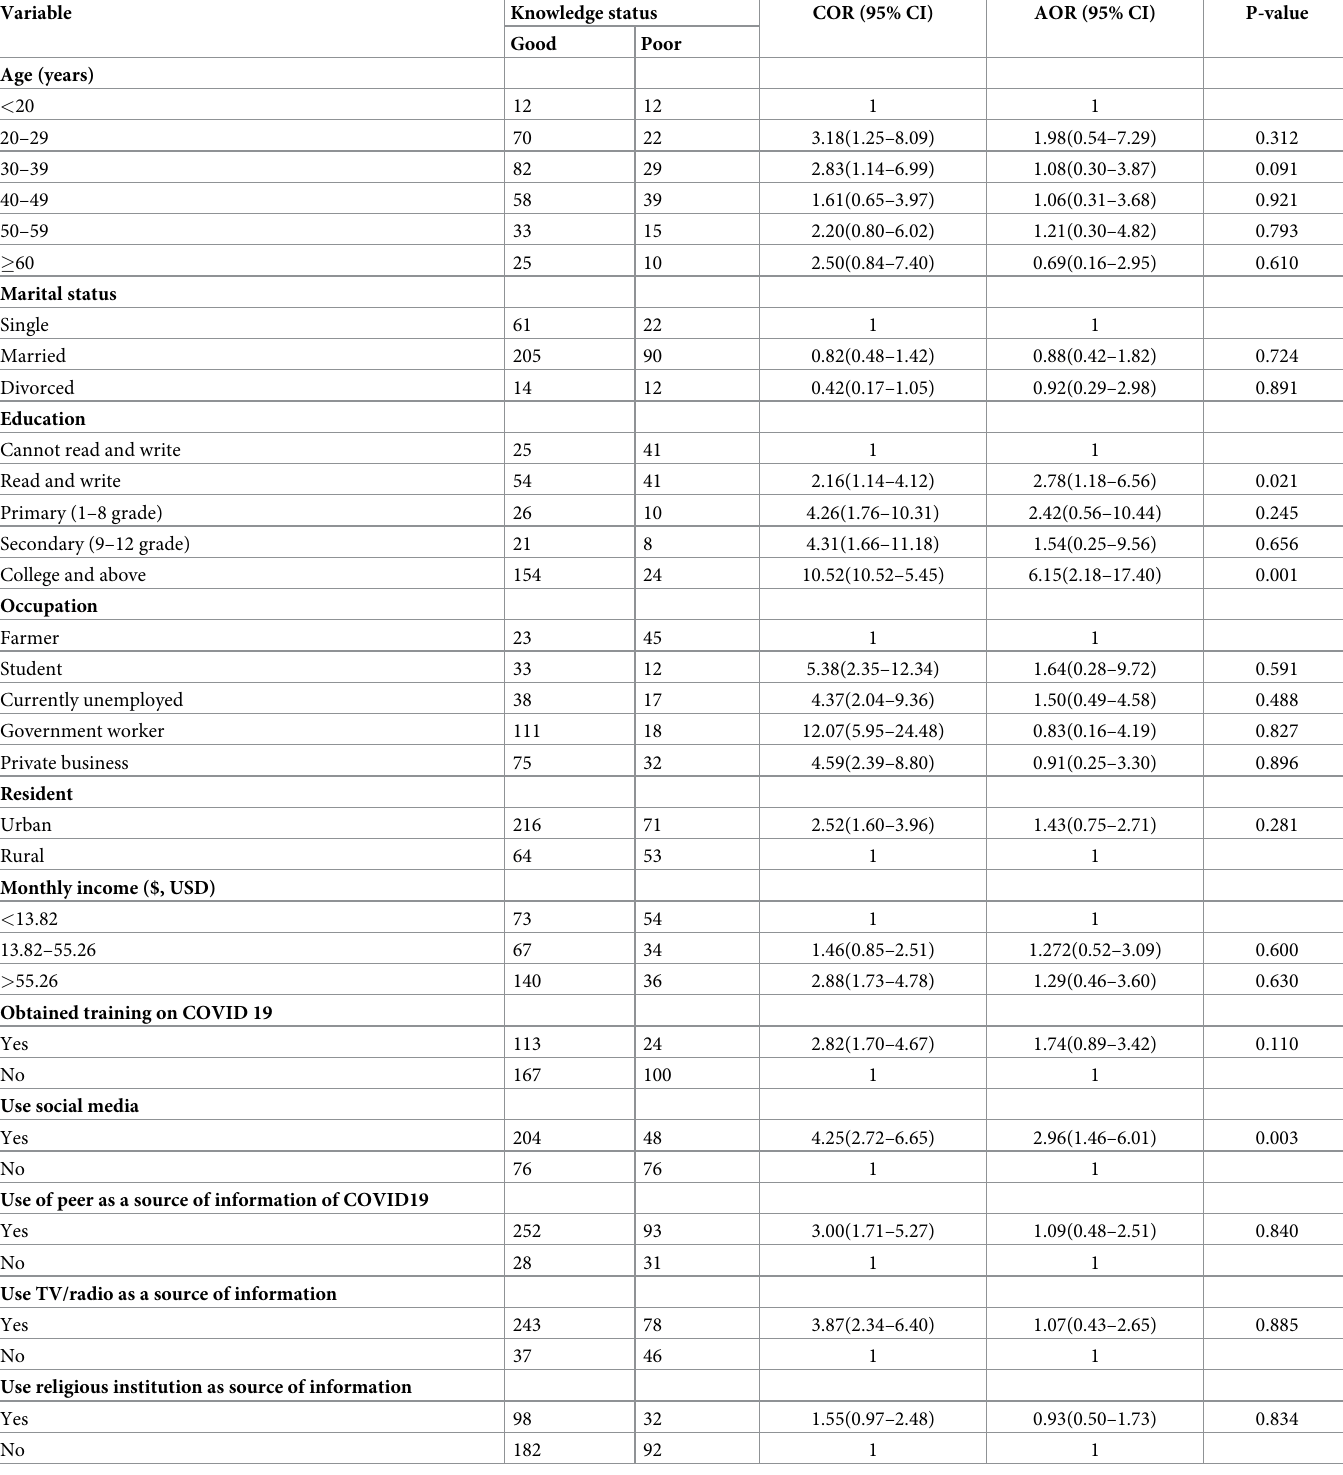
Table 5. Factors associated with knowledge towards COVID-19 prevention among adult visitors in hospitals of South Gondar zone, Northwest Ethiopia, August 1 to 30,